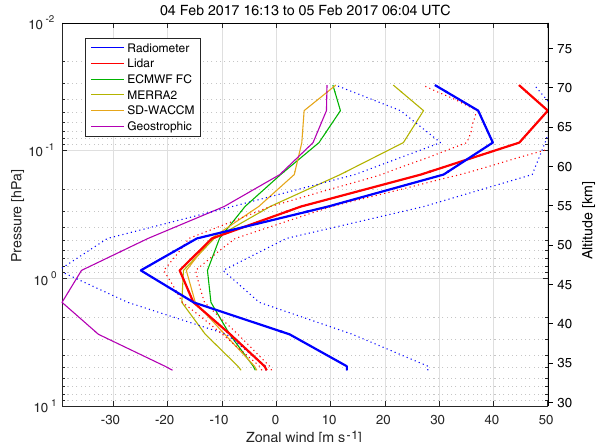
Figure 8. Mean profile of zonal wind for the part of the night from 4 to 5 February 2017 when both measurement systems were oper- ated in night mode. For reasons of clarity only profiles convolved according to Eq. (2) are shown here, the same plot including the unconvolved wind profiles can be found in the Fig. S3 (second row, fourth column). The blue and red dotted lines represent the error bands of the radiometer and lidar observations.